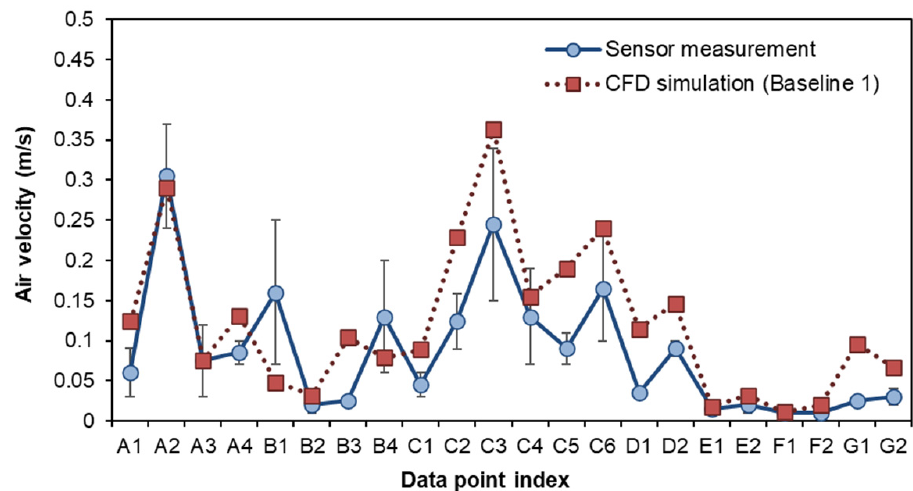
Figure 6. Comparison of airflow velocity from simulation and field measurement.